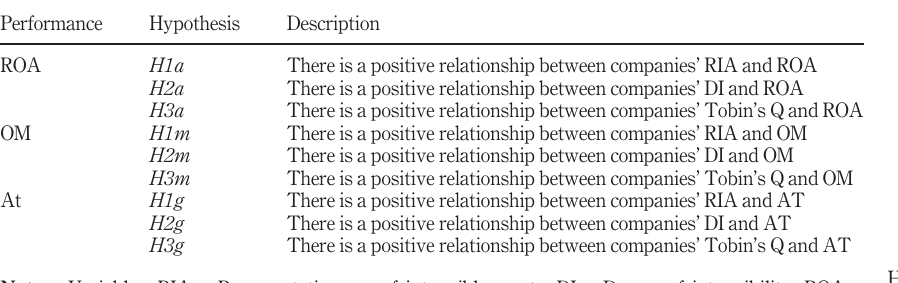
Table 2. Hypotheses